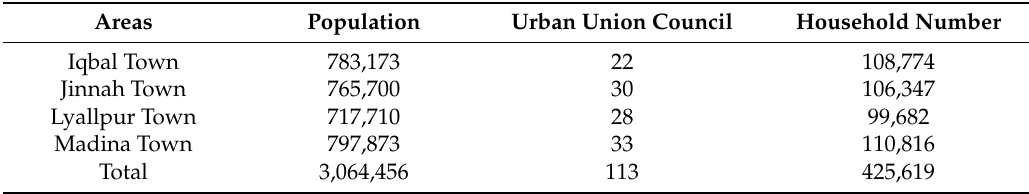
Table A1. Urban population in Faisalabad (Census